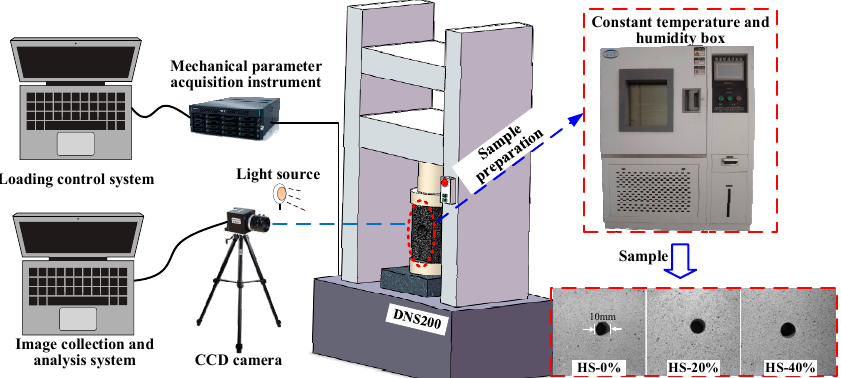
Figure 1. Test system and